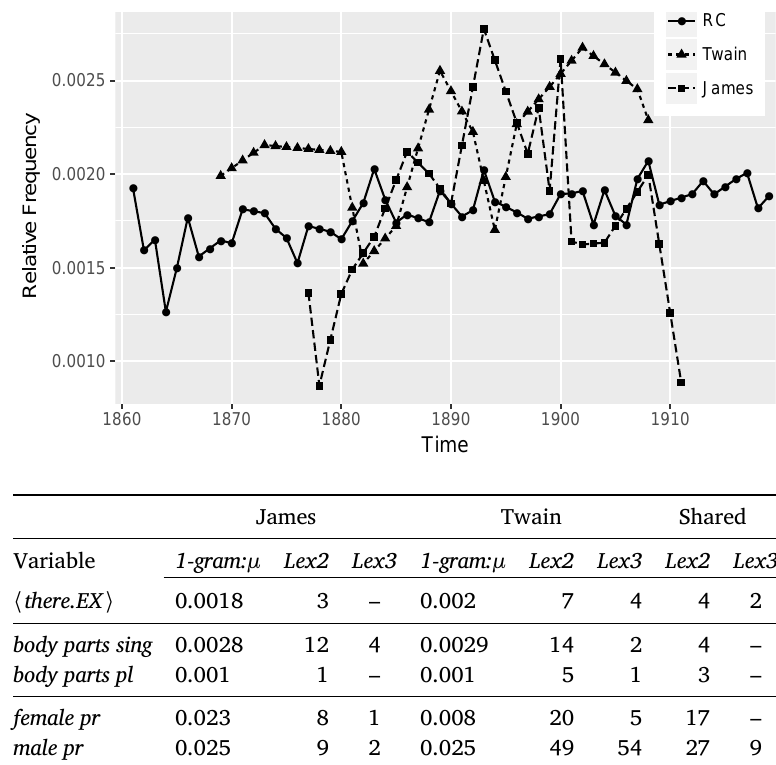
Frequency and number of feature types for